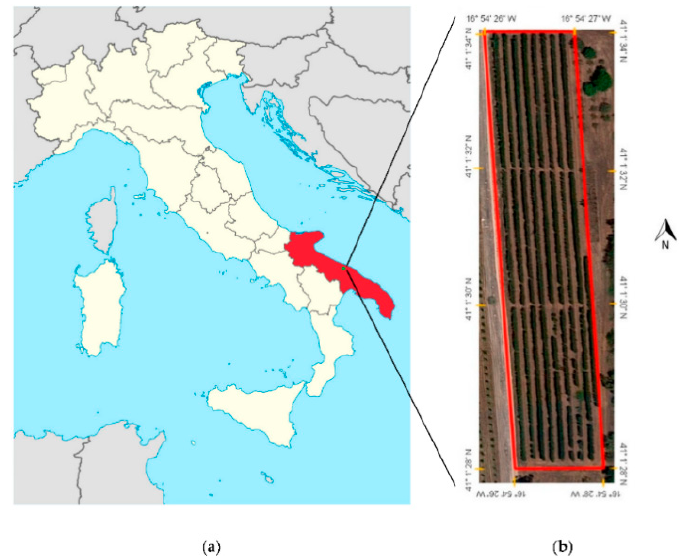
Figure 2. General location of the study area: ( a ) Apulia region, Italy; ( b ) overview of the image obtained by satellite of the area under